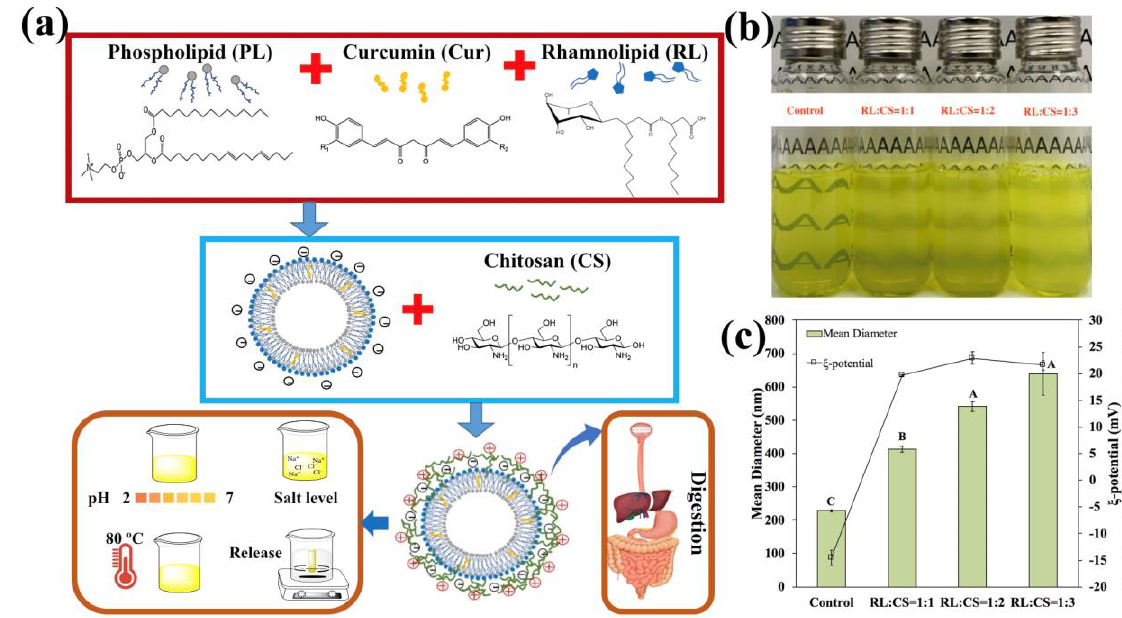
Figure 1. ( a ) The formation scheme of chitosan (CS)-coated curcumin-loaded rhamnolipid liposomes (Cur-RL-Lips); ( b ) visual appearance of liposomes with different ratios of RL/CS (RL:CS =1:1, 1:2, and 1:3); ( c ) mean diameter and ζ -potential of liposomes with different ratios of RL/CS. Samples denoted by different capital case letters (A – C) were significantly different ( p < 0.05) when compared between different RL/CS ratios.